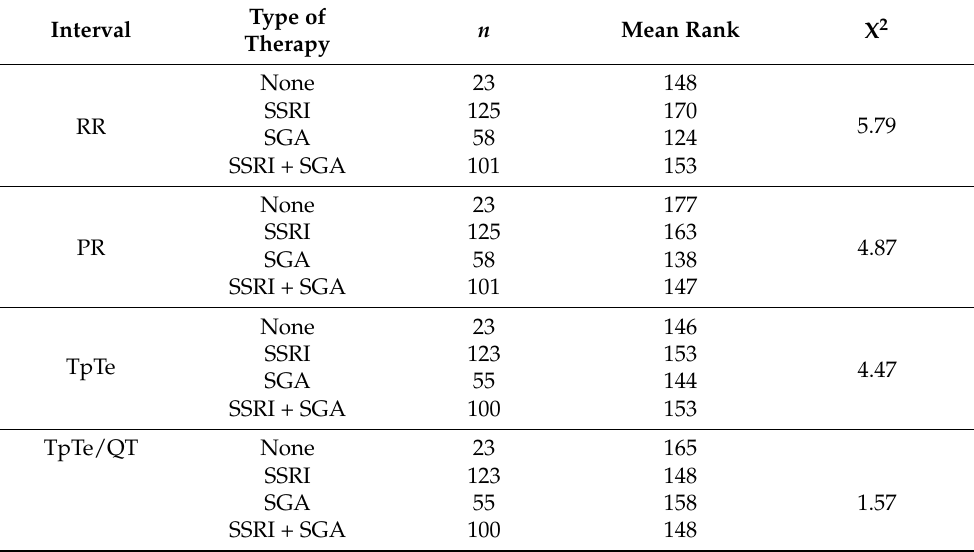
Table 4. The effect of SGA and SSRI combination on RR, PR, TpTe intervals and TpTe/QT. Type of n Mean Rank X 2 Interval Therapy